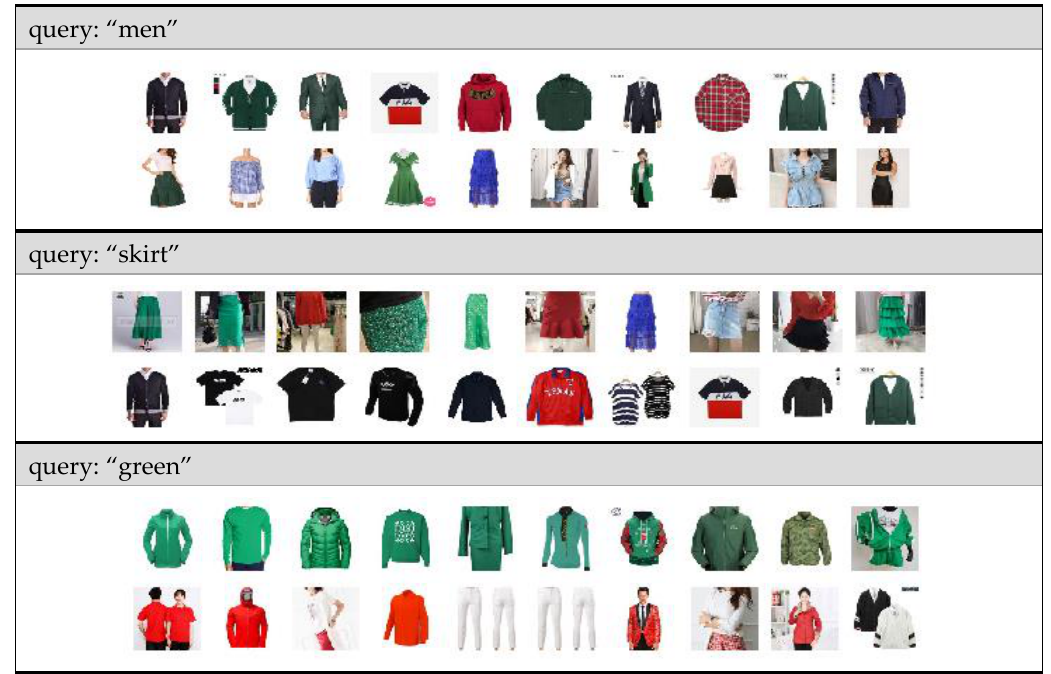
Figure 7. Template for the fashion product search results.